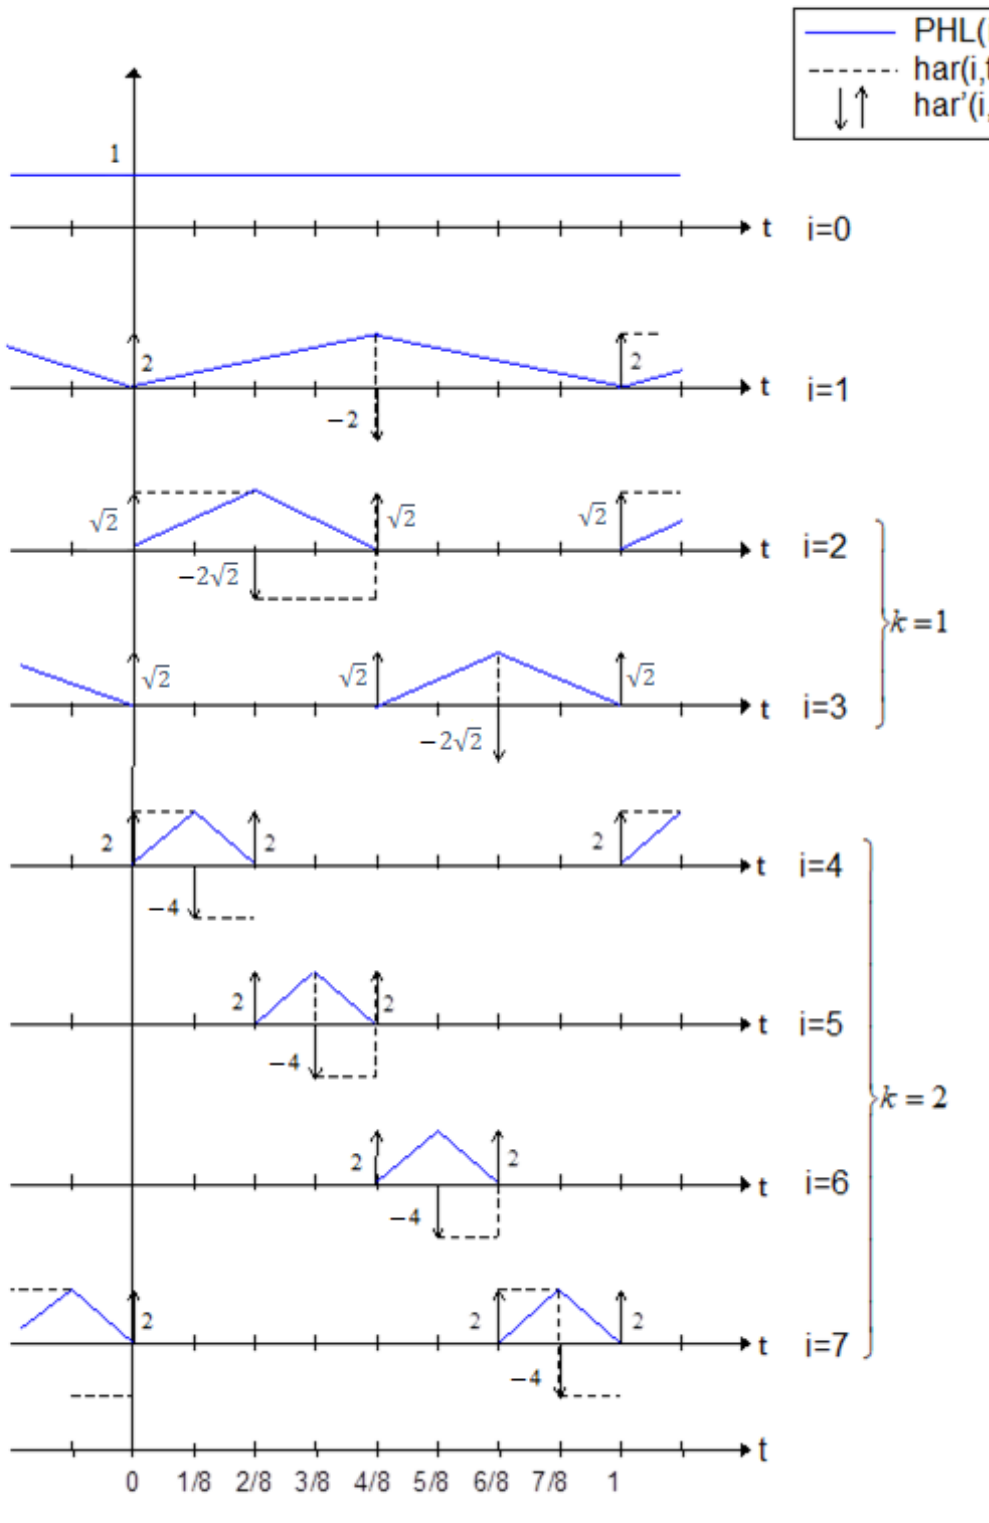
Figure 1. Set of PHL functions for N =